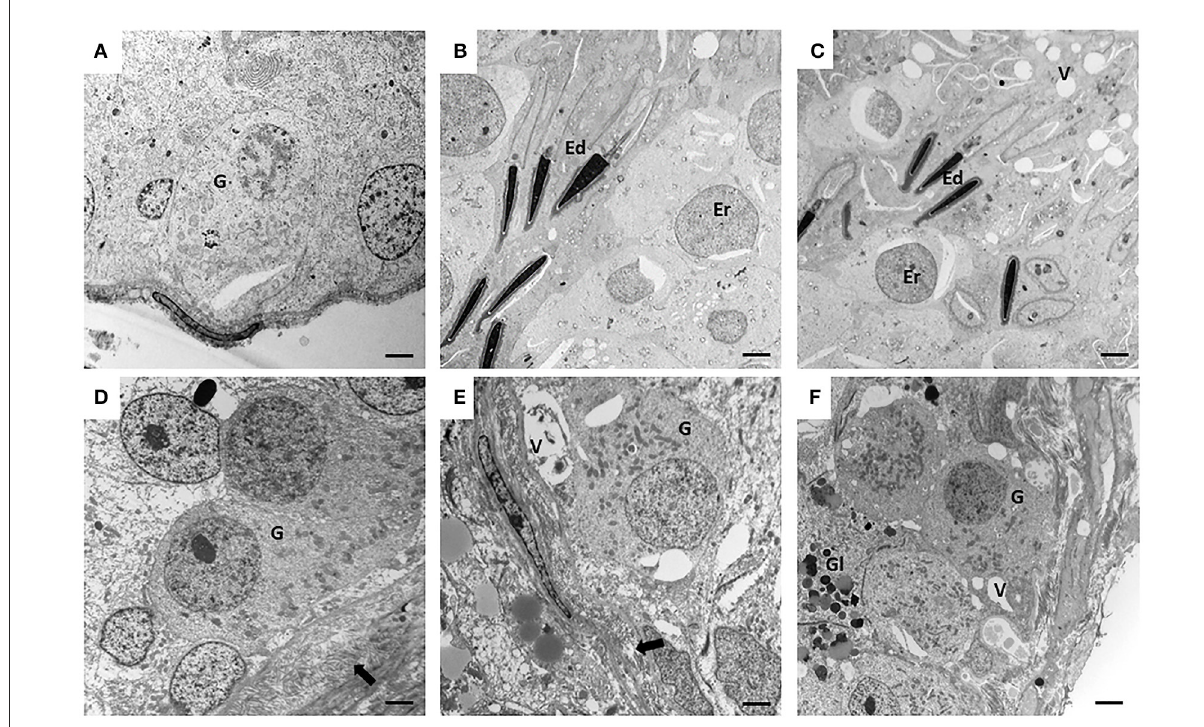
FIGURE2 Electron microscopy (EM) of canine testes from the control groups (CTRL) (A–C) and from cryptorchidism (CO) (D–F) . It is observed in the peripubertal stage, the presence of gonocytes in migration phase (A) and with small pseudopodia touching the basement membrane (D) . In the young adult stage of the second row, a clear spermatogenesis is observed in the CTRL testis (B) , unlike the CO testis, which shows the presence of a gonocyte-like cell with thickening of the basement membrane (E) . In the senile stage, the CTRL testes still preserve spermatogenesis (C) with disorganization of the epithelium, and cells morphologically similar to gonocytes (F) were observed in the CO. Gonocyte (G), round spermatid (Er), elongated spermatid (Ed), basement membrane (arrow), vacuoles (V), glycogen (Gl). Electron microscopy. Bar scale: 2 µ m.